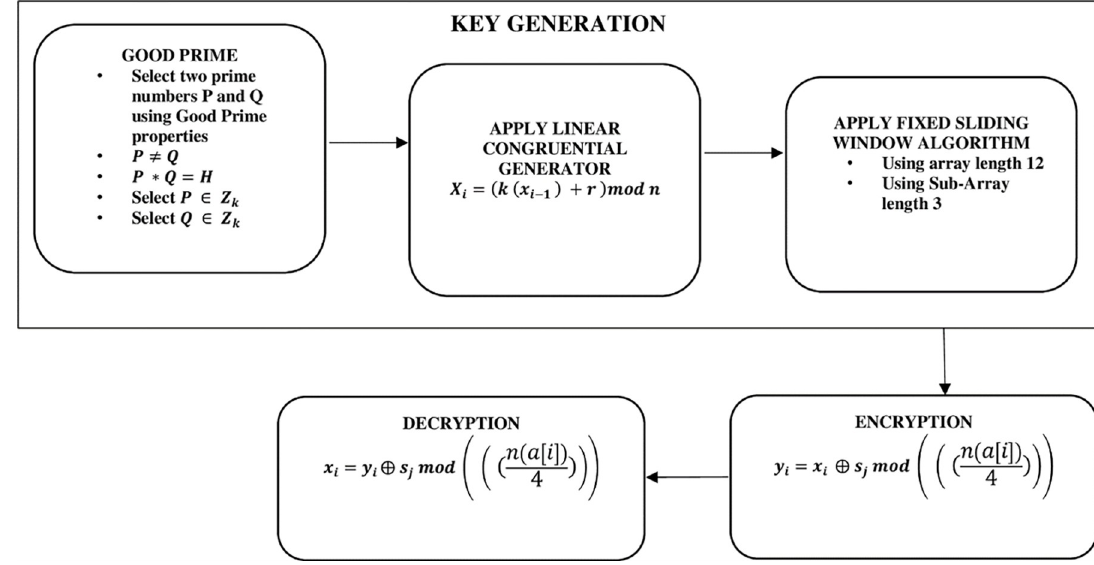
Fig 4. Workflow diagram of proposed NCS